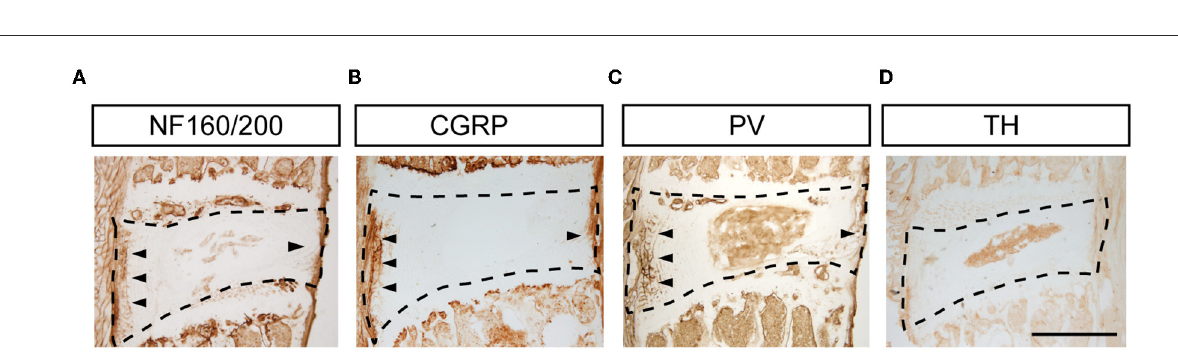
< 30 µ m) (26). Growing evidence indicated that CGRP, one of the inflammatory mediators and the marker for nociceptive C